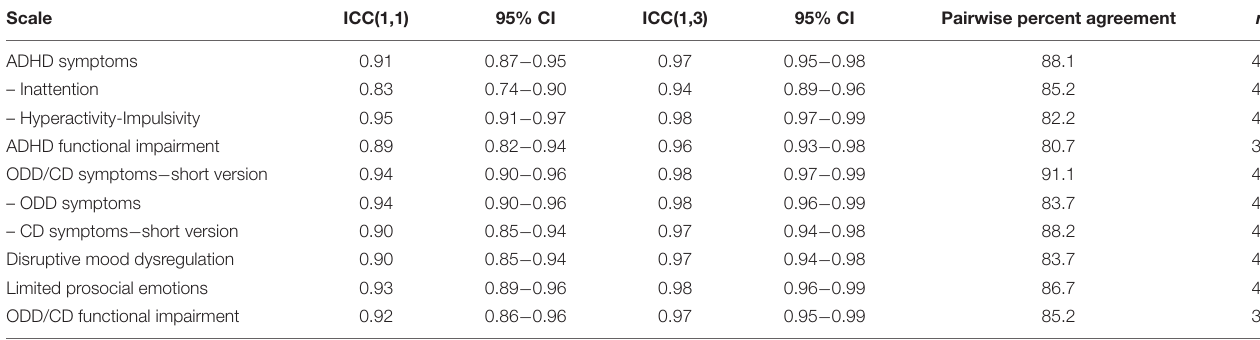
TABLE 3 | Interrater reliability of the ILF-EXTERNAL scales.